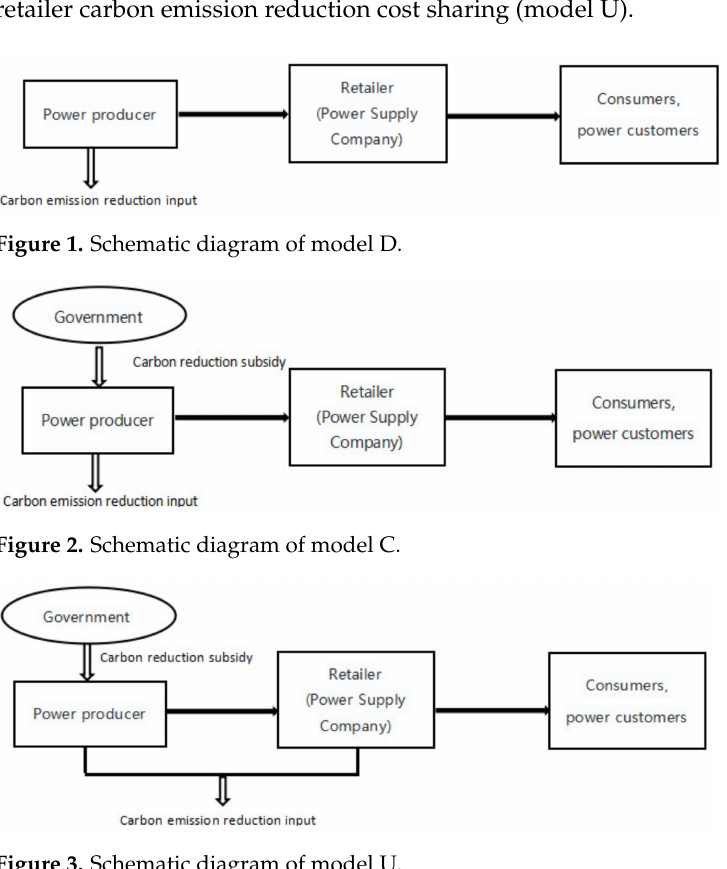
Figure 3. Schematic diagram of model